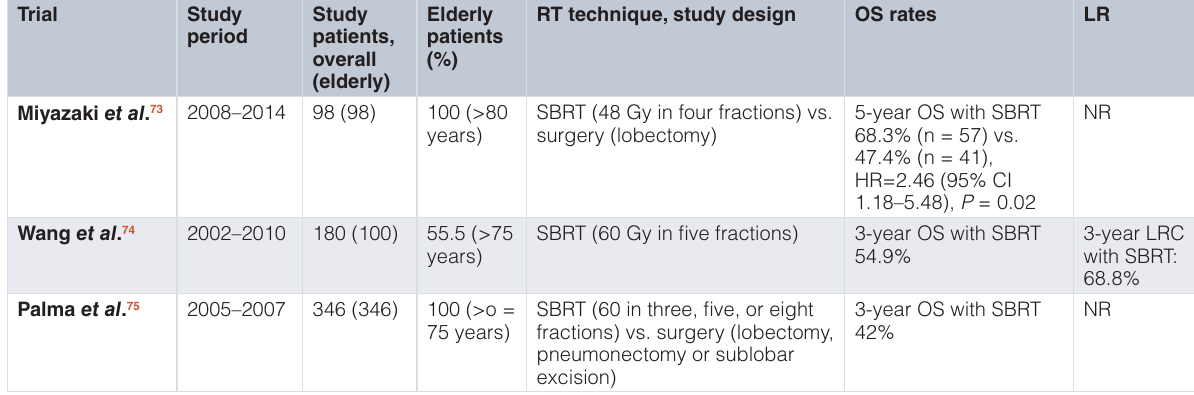
Table 6. Retrospective studies examining outcomes between stereotactic body radiotherapy and surgery in older adult patients with early stage non-small cell lung cancer.